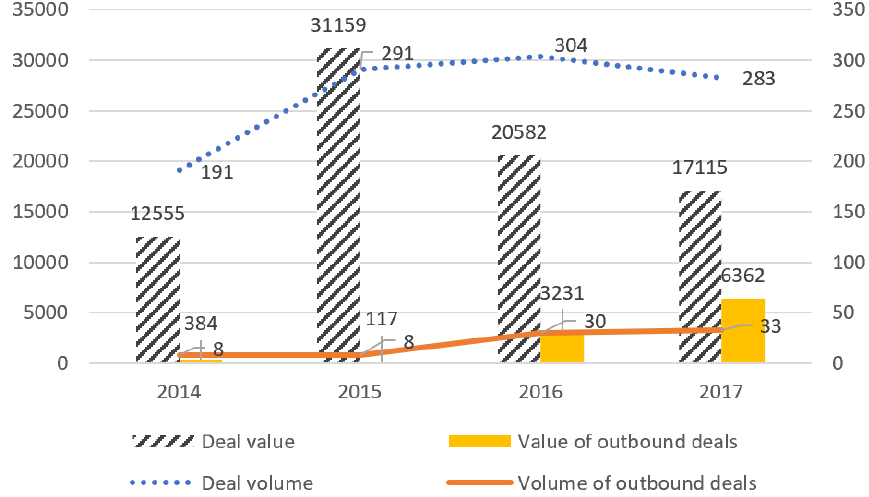
Figure 6. Deal value and volume of the pharmaceutical industry in China (million dollars). Data resource: www.pwccn.com.